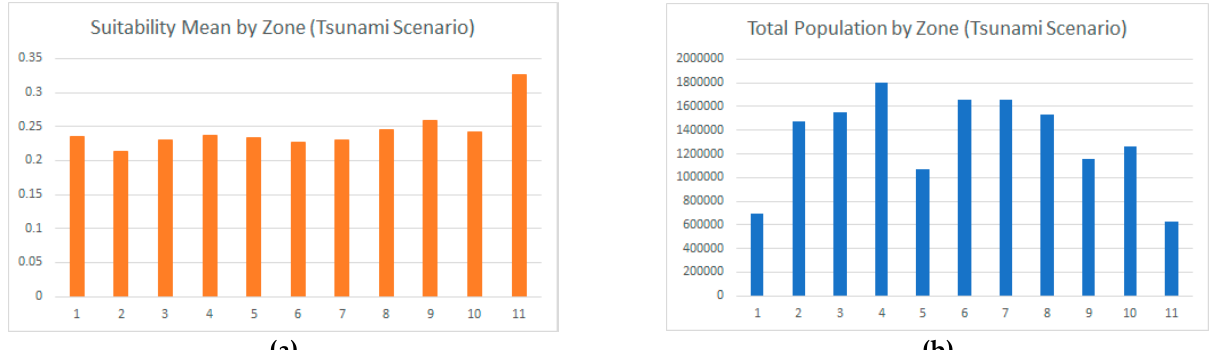
Figure 7. ( a ) Suitability Mean and ( b ) Total population by Zone in Tsunami Scenario. The overall similarity between relief zones for both of the scenarios are compared with the spatial V-measure. A V-measure of 0.89 indicates two relief zone maps are highly associated. The local differences between relief zones are depicted in Figure 8. Blue indi- cates low inhomogeneities (high degree of similarity), while yellow stands for high inho- mogeneities (low degree of similarity) between two scenarios.